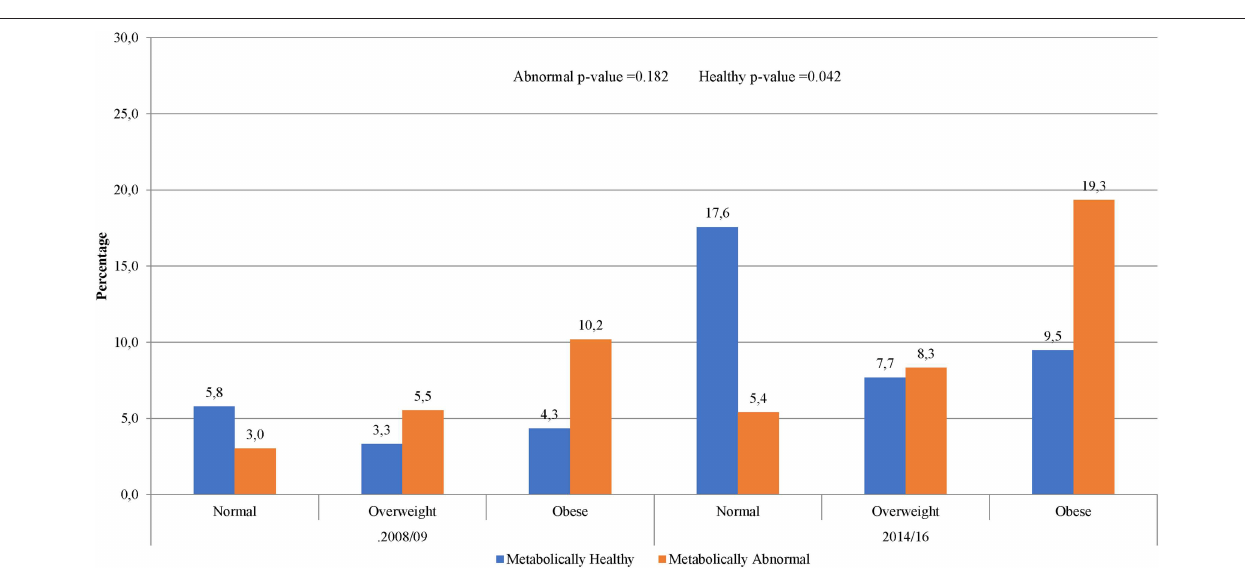
trend was observed in 2014/16. This apparent different pattern